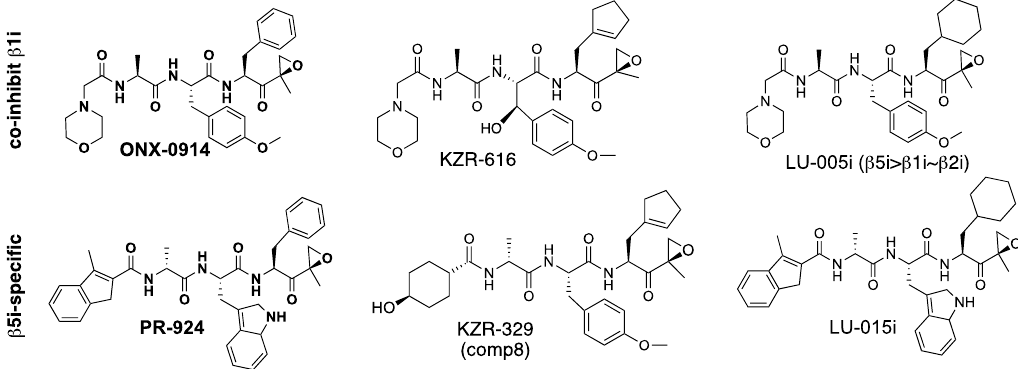
Figure 4. Epoxyketone β 5i inhibitors. Commercially available compounds are